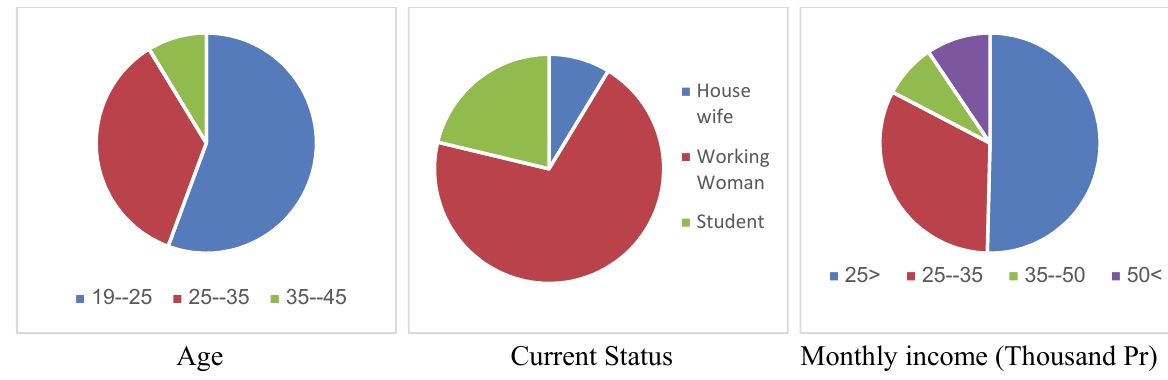
Fig. 1. Personal characteristics of the participants